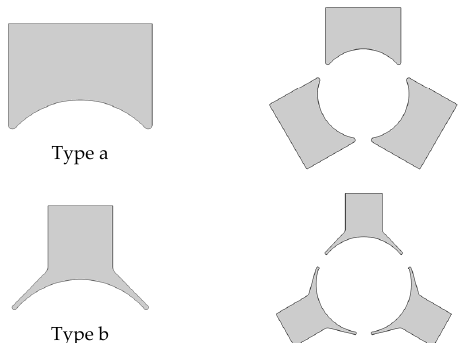
Figure 5. Stators (outer geometry parts).